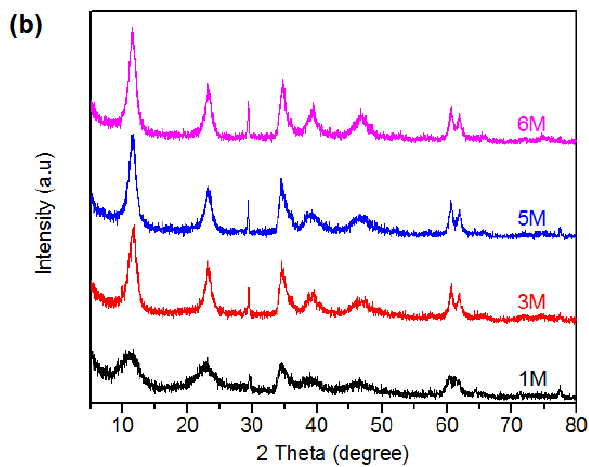
Figure 8. ( a ) The influence of leaching acid concentration on the CO 2 sorption capacity of Mg-Al-CO 3 LDH- x M ( x = 1, 3, 5, and 6) samples, and ( b ) the XRD patterns of Mg-Al-CO 3 LDH- x M ( x = 1, 3, 5, and 6) samples.